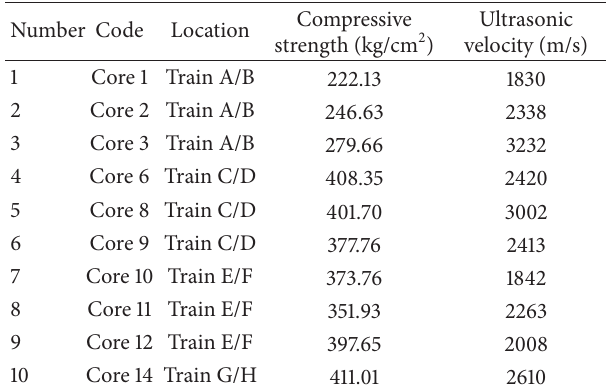
Table 3: Compressive strength and ultrasonic velocity of core- drilled